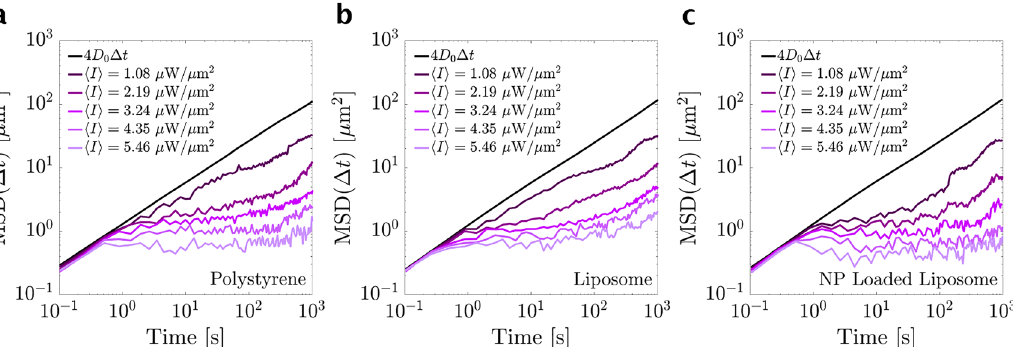
Figure 3: Mean square displacement of Brownian particles on a logarithmic scale as a function of time in increasing speckle field intensity, for (a) a polystyrene, (b) a liposome, and (c) an NP-loaded liposome. Black lines represent Einstein’s free diffusion law. The initial position of the particles is chosen randomly and the reported data in each of the figures are the average of more than 1000 different trajectories in a time duration of 1000 s. The average speckle intensity is increased from 1.08 to 5.46 μ W/ μ m 2 . In all cases, a transition from trapping at high speckle intensities to subdiffusion at low speckle intensities can be recognized.